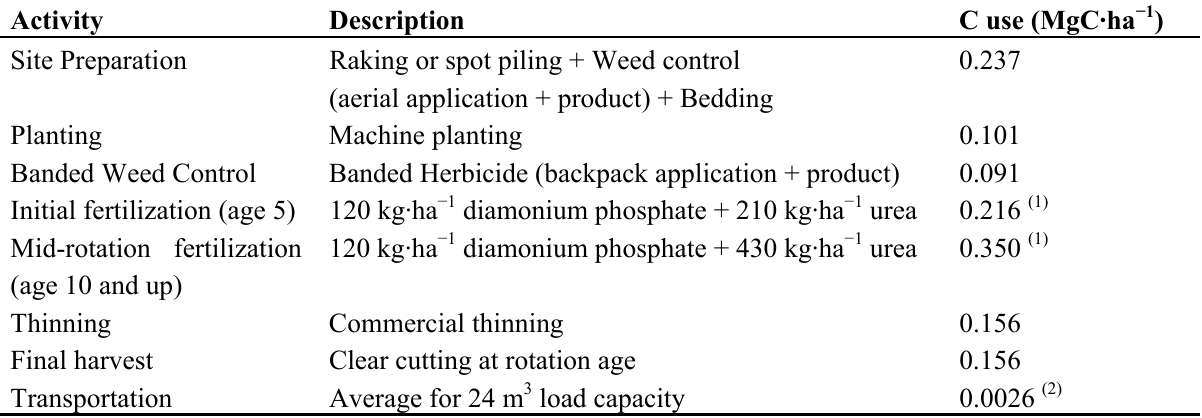
Table 4. Carbon used in silvicultural activities and product transportation to mill